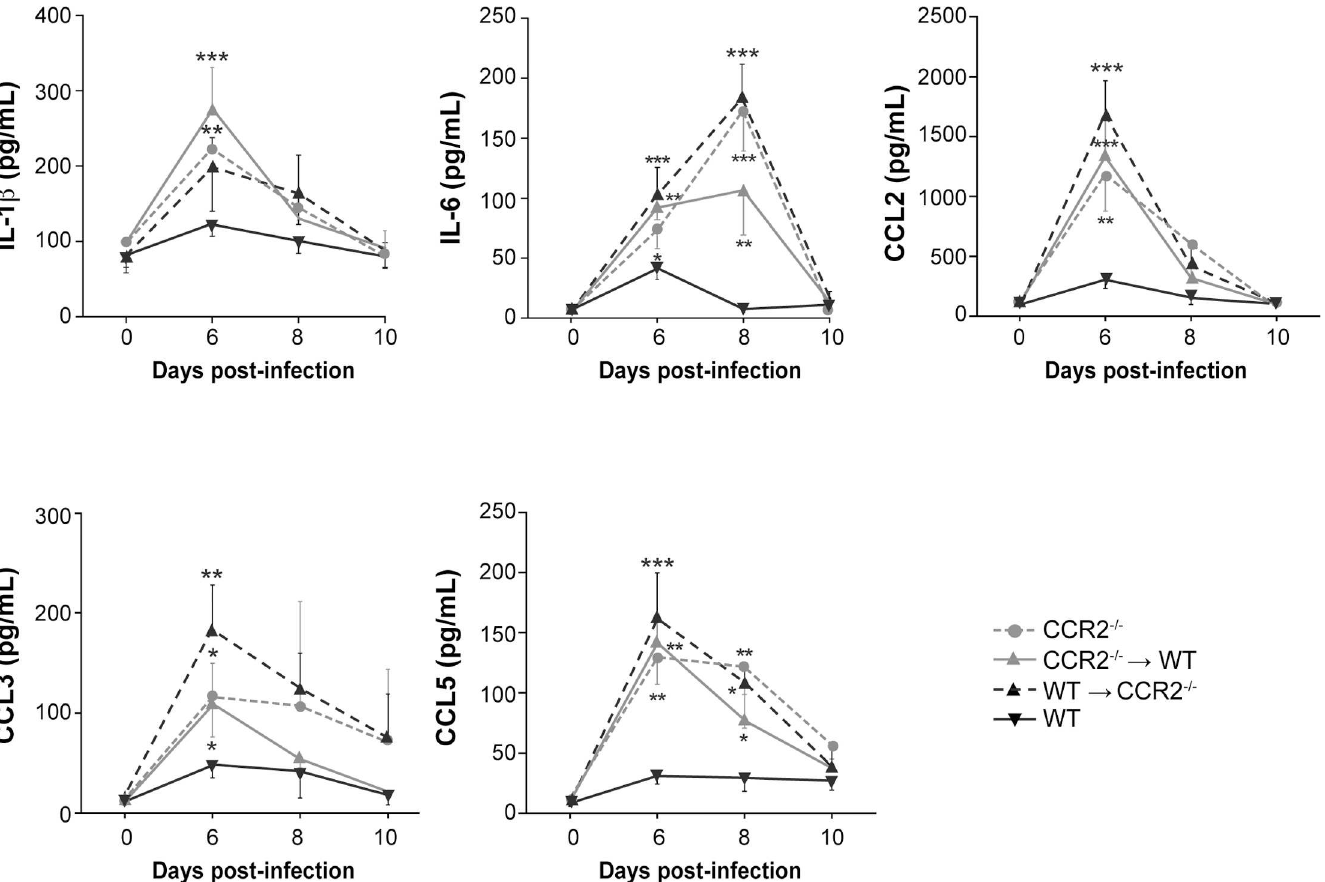
Fig 4. Impact of CCR2 deficiency in resident cells of the CNS or in the hematopoietic systemon cytokines and chemokines production during HSE. Levels of cytokines and chemokines in brain homogenates of wild-type(WT) C57BL/6, CCR2 -/- , CCR2 -/- ! WT and WT ! CCR2 -/- mice were evaluatedprior to (day 0) and on days 6, 8 and 10 followingintranasalinfectionwith 1.2x10 6 PFU of HSV-1. Levels of cytokines and chemokines were measuredusing magneticbead-based immunoassay. Results are expressedin pg/mL of brain homogenates and represent the means ± standard deviations of 4 to 5 mice per group at each time point. Statistical analyseswere performed using a one-wayanalysisof variance(ANOVA) with Tukey’s multiplecomparisonpost-test. Statistically significantresults obtainedin CCR2 -/- , CCR2 -/- ! WT and WT ! CCR2 -/- comparedto those of the WT group are indicatedas follows: * , P < 0.05; ** , P < 0.01; *** , P < 0.001.